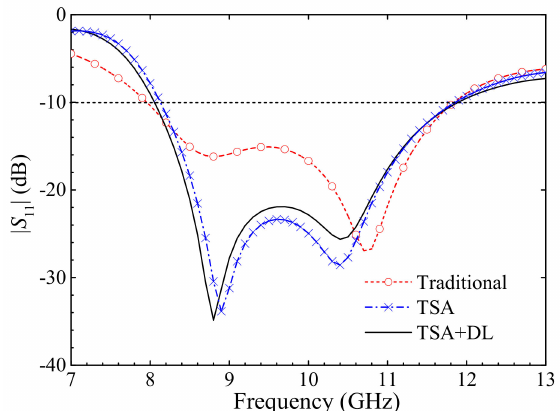
Figure 2. Simulated reflection coefficient of the different structures of the tapered slot antenna.